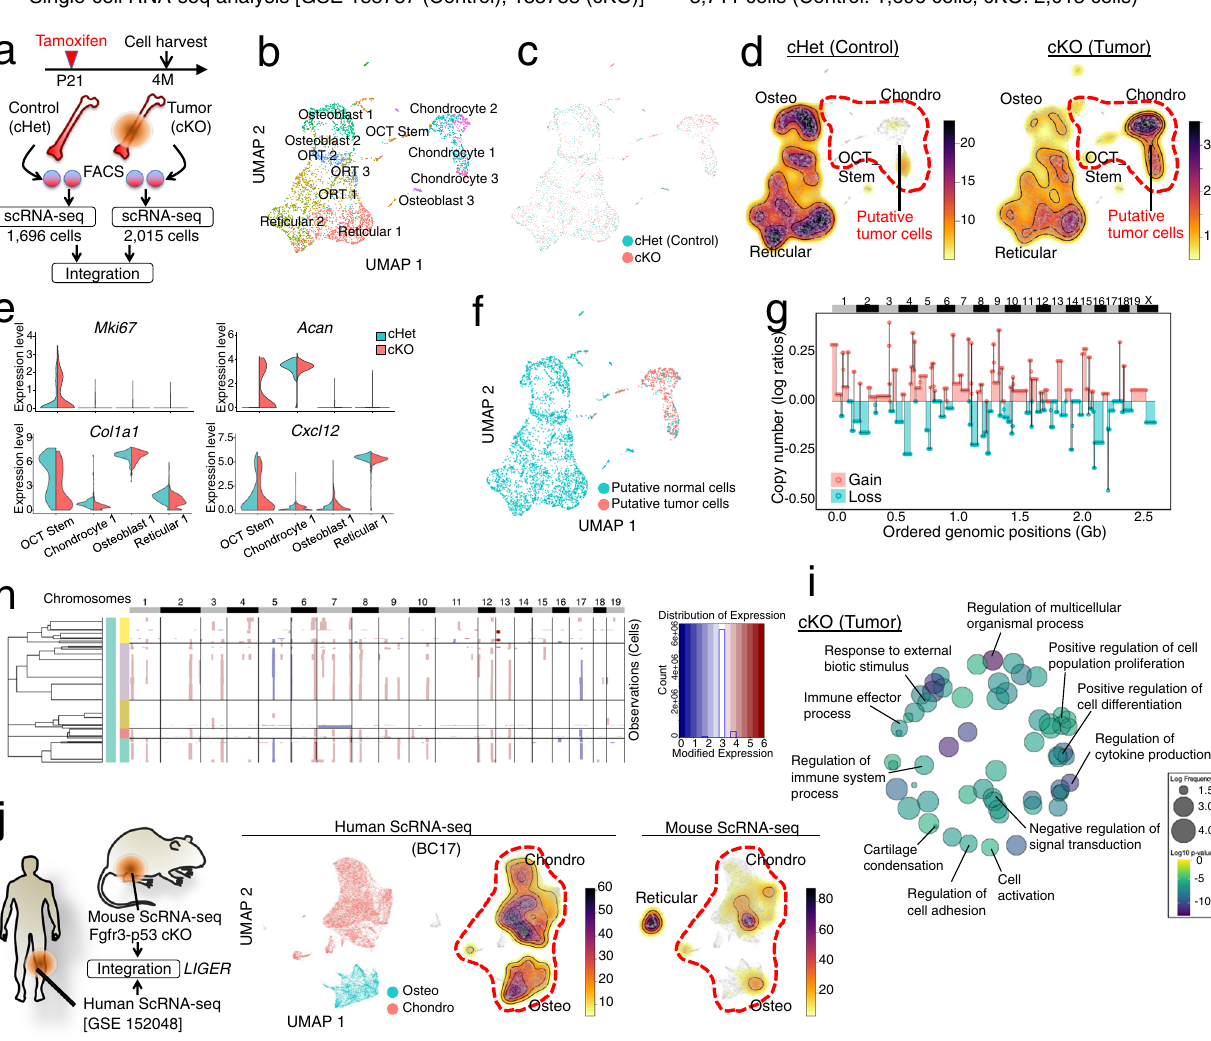
CopyKAT. Blue: putative normal cells. Red: putative tumor cells. g Genome-wide visualization of copy number variations in putative tumor cells inferred by Copy- KAT. h Hierarchical clustering of putative tumor cells with different patterns of copynumbervariationinferredbyinferCNV. i REVIGOplotofgeneontologyterms enriched among genes upregulated in putative tumor cells. The p values were calculatedusingGOrilla ’ sone-sidedtestbasedonthehypergeometricdistribution, with a fl exible p value cutoff applied for multiple testing correction. The results were subsequently transferred to REVIGO for visualization. j Mouse-human tumor data integration. Left: Diagram for LIGER data integration of single-cell